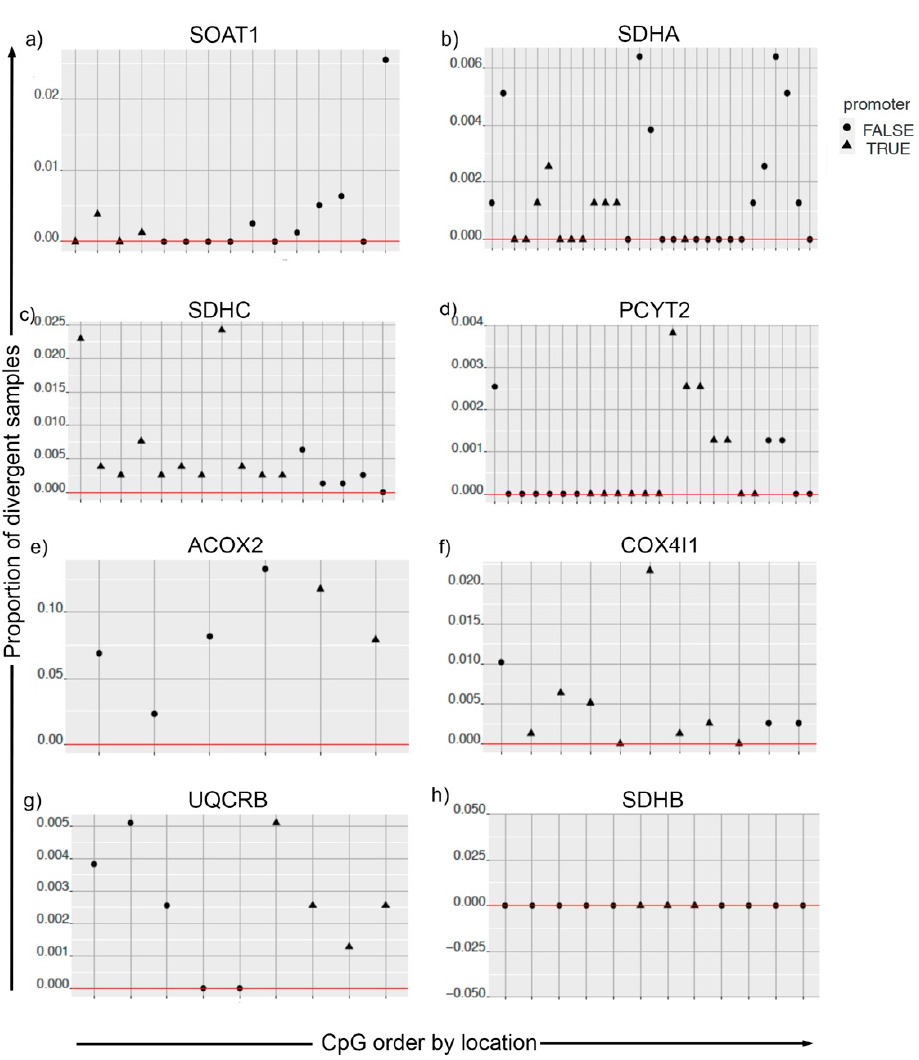
Figure 5. Divergence analysis for methylation pattern of metabolic genes in cancer and solid tissue normal samples. For plots ( a – h ), the CpGs on the x-axis are ordered by their location. The y-axis is the proportion of tumor samples that are divergent both in the expression space and methylation space simultaneously. CpGs mapped to promoter regions are indicated by the shape of the